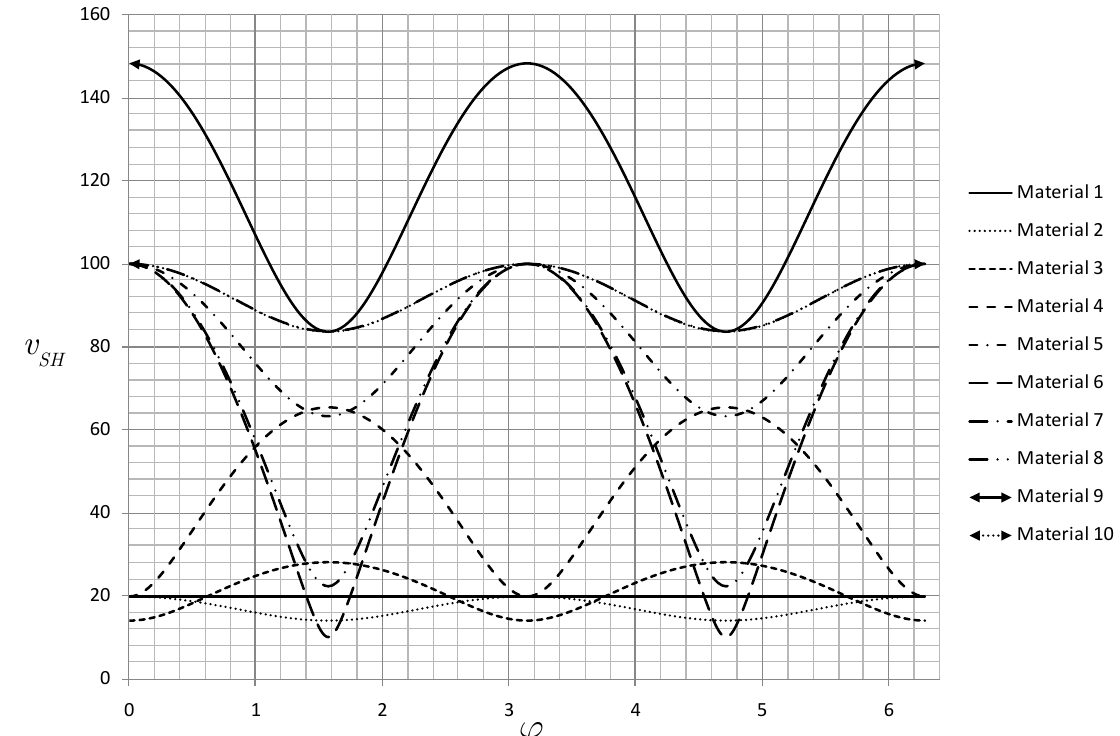
Fig. 5. Comparison of SH-wave velocity as a function of incident